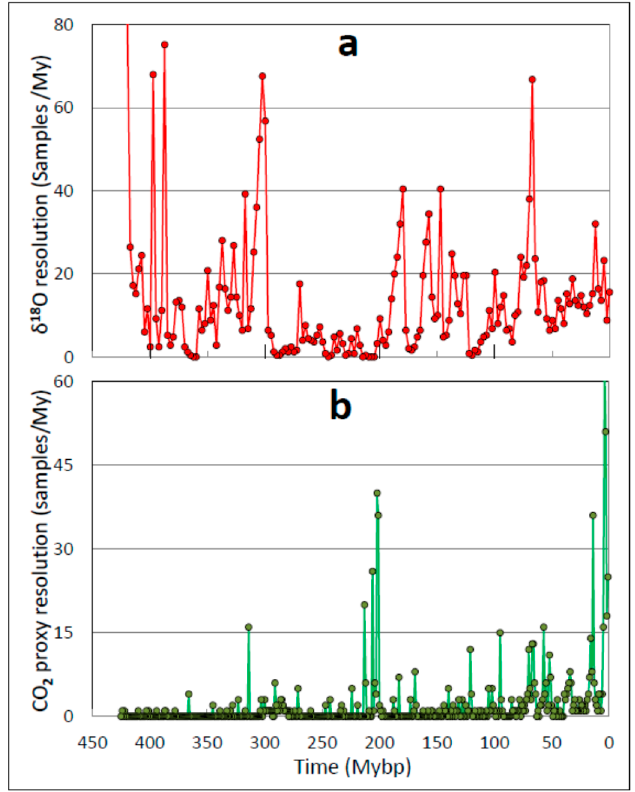
Figure 2. Sample resolution of climate proxies over the Phanerozoic Eon. Shown are sample datapoints per My for δ 18 O ( a ) and atmospheric CO 2 concentration ( b ). Zero values correspond to time periods in which no measurements are available.